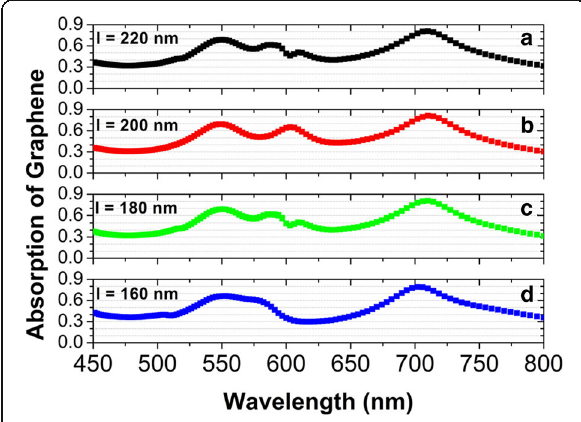
Fig. 7 The same as in Fig. 6, but for the center distance l between the nearest-neighbor Ag nanodisks to be decreased from 220 to 160